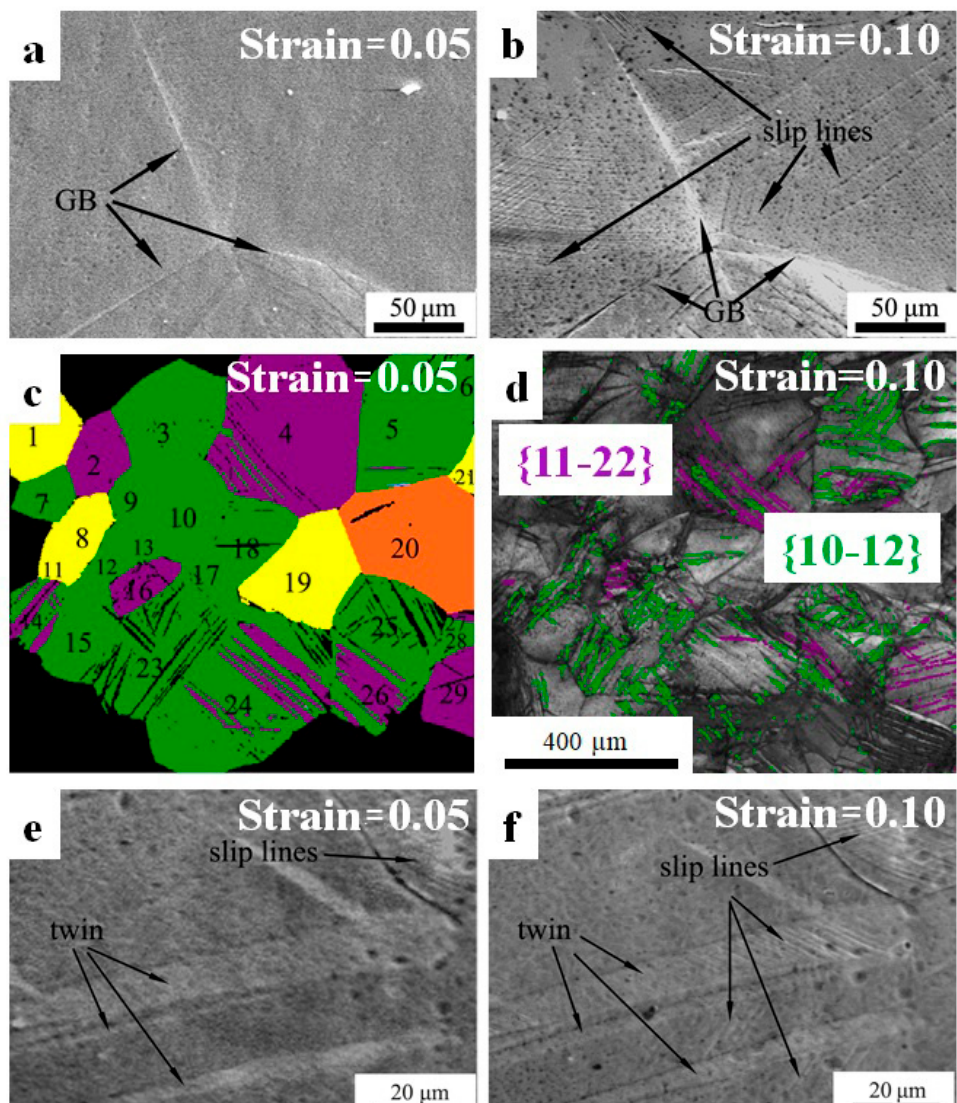
Figure 5. SEM figures at the same place with a strain of ( a ): 0.05, ( b ): 0.10 indicating the slip lines; ( c ): the model diagram with a strain of 0.05 where twinning is going to nucleate and grow. The place painted green, purple, orange, and yellow indicate {1012} twins, {1122} twins, both of the two twinning systems, and no twins, respectively; ( d ): microstructure at 0.10 strain level, with {1012} twin boundaries (in green) and {1122} twin boundaries (in purple); SEM morphology with a strain of ( e ): 0.05 ( a , f ): 0.10.